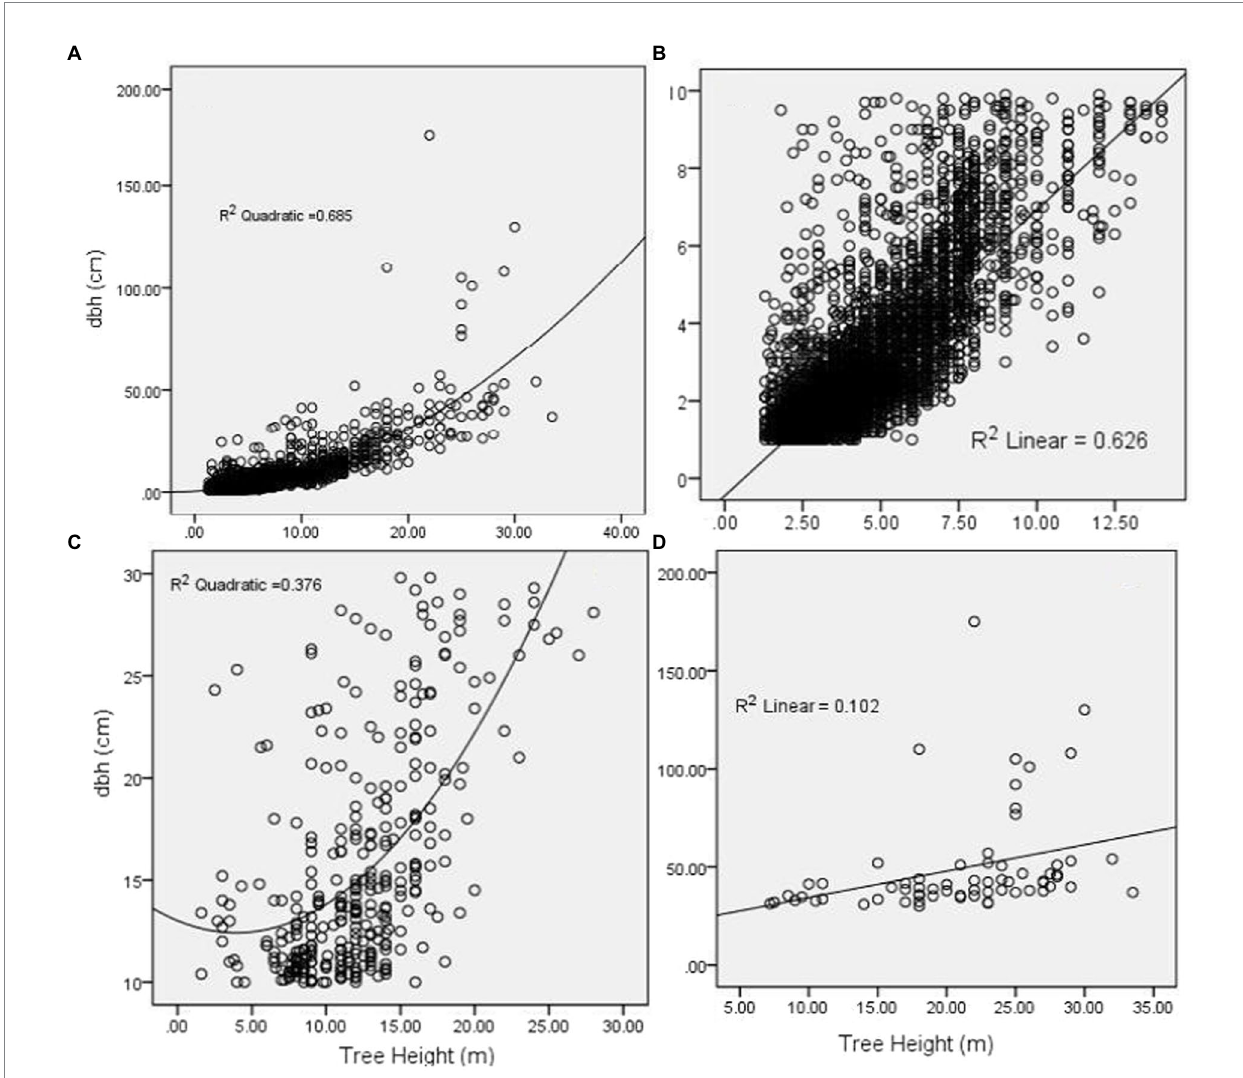
FIGURE 6 A quadratic and linear relationship between DBH and height for pooled data (A) , DBH below 10 cm (B) , DBH between 10 and 30 cm (C) , and DBH above 30 cm (D)